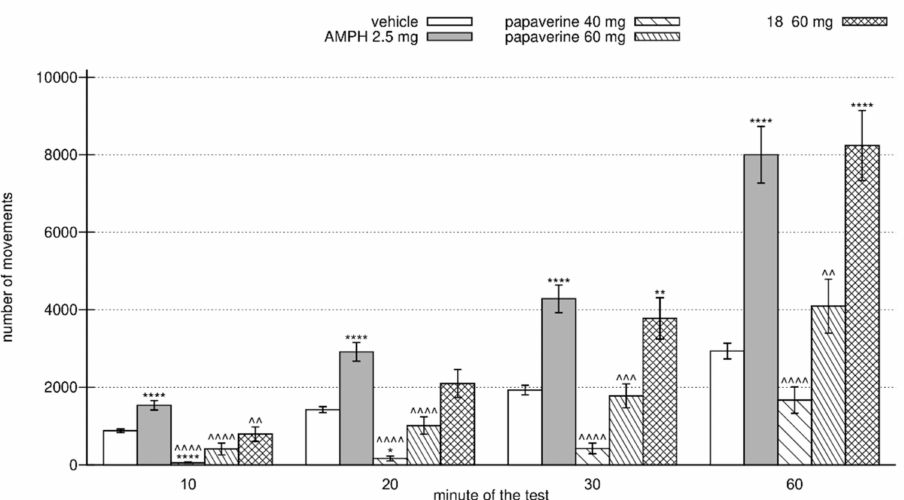
Figure 6. E ff ects of papaverine and compound 18 on d -amphetamine-induced hyperlocomotor activity in CD-1 mice. Data are expressed as the mean of the number of movements recorded after 10, 20, 30, and 60 min of the papaverine-treated groups (at doses of 40 and 60 mg, respectively) and the compound 18 -treated group (at a dose of 60 mg) ± S.E.M. * p < 0.05, ** p < 0.01, **** p < 0.0001, versus the respective vehicle-treated group, ˆˆ p < 0.01, ˆˆˆ p < 0.001, ˆˆˆˆ p < 0.0001, and versus the respective